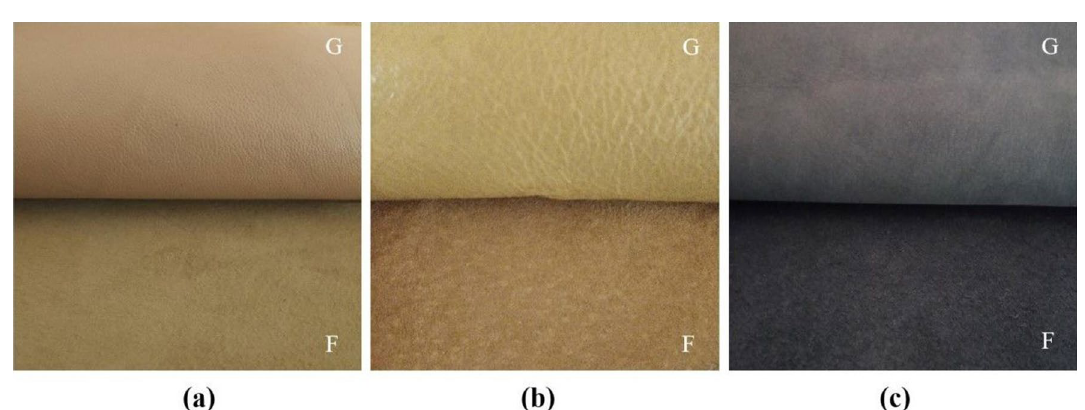
Figure 1. Tested material—leathers, for which samples A1 ( a ), A2 ( b ) and A3 ( c ) were collected; G grain side, F flesh side. Source: Author’s own